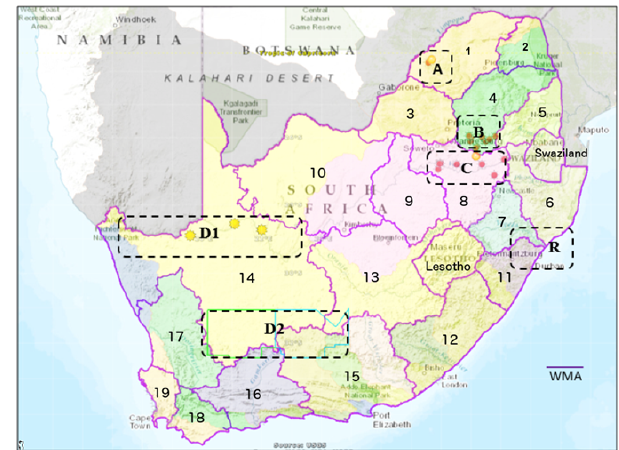
Figure 2. South African Water Management Areas and Energy Pro- ducing Regions (A: Waterberg (Lephalale); B: Mpumalanga, Wit- bank; C: Mpumalanga, Secunda; D1: Northern Cape, Upington; D2: Northern Cape, Karoo. The WMAs are numbers as per the original definition given in the National Water Resources Strategy (DWAF,